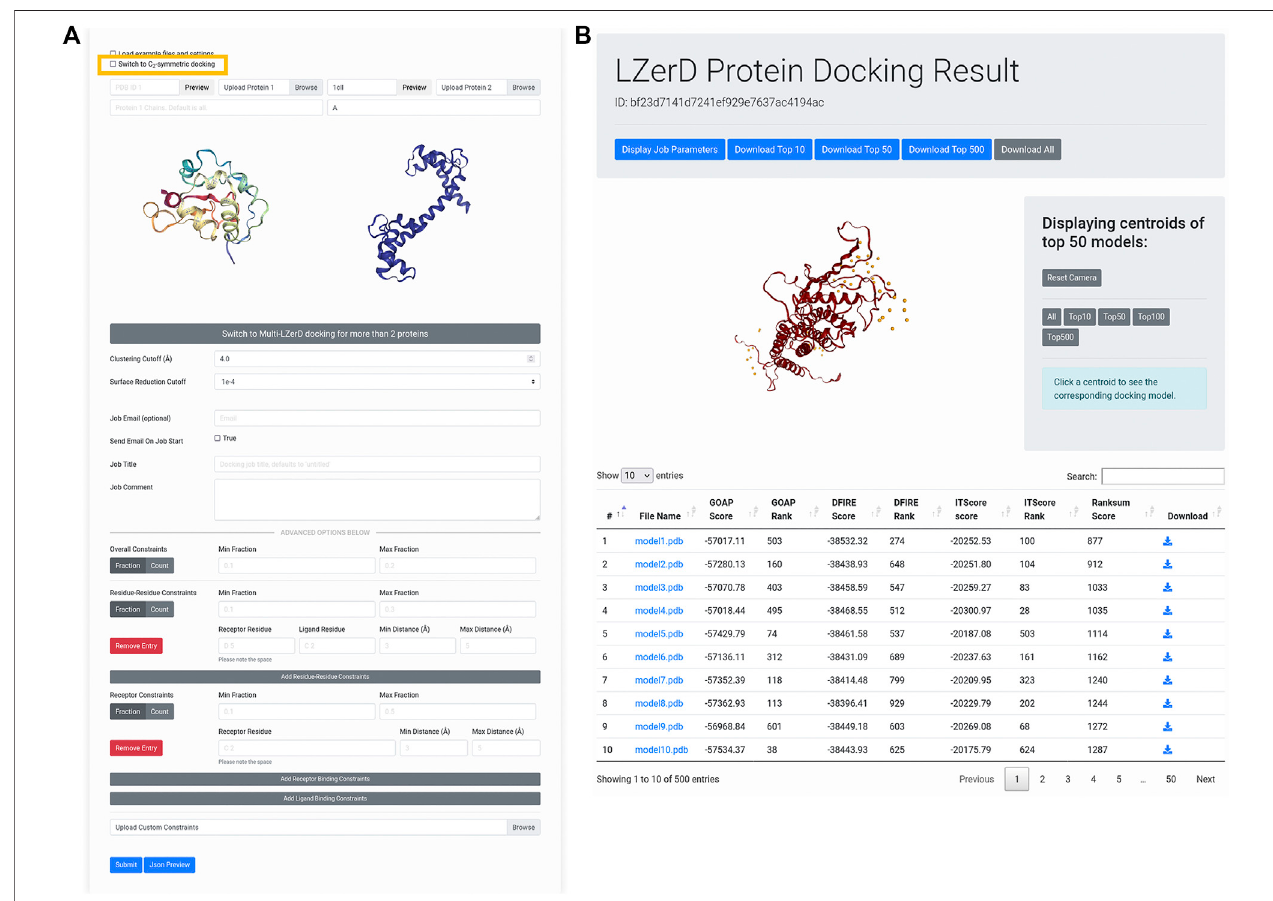
FIGURE 2 | Submitting and interpreting protein docking job. (A) the job submission page. The fi gure represents a situation that a structure model of Protein 1 is transferred from AttentiveDist and thestructurefor Protein 2will be fetched from PDB. Thecheckbox for performing C 2 Symmetry docking ishighlighted byrectangle in yellow. (B) dockingresults page.Onthetopofthepanel, adistributionofcentroidsofthedockedposesoftheligandstructures areindicatedwithspheres.Byclickinga sphere, the docked structure of the pose will be